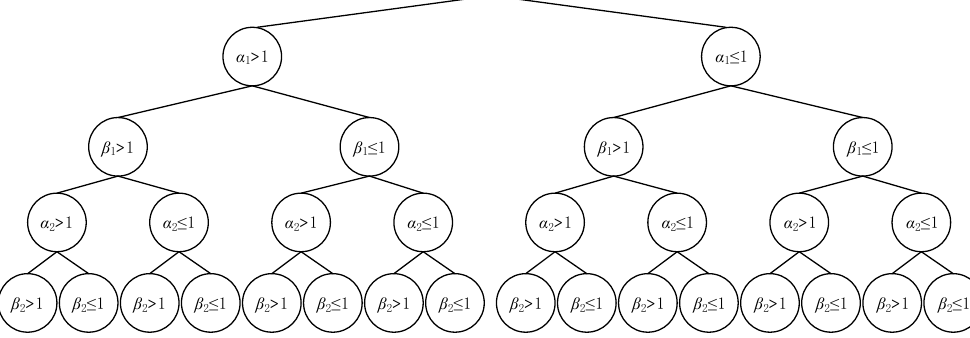
Figure 2. Tree diagram of combinations of fractional orders.